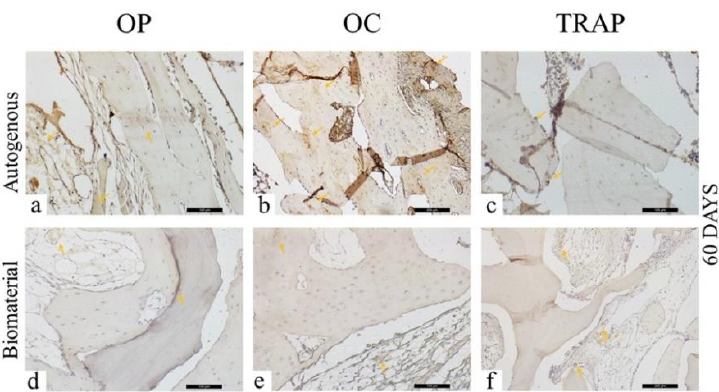
Figure 8. Osteopontin (OP), Osteocalcin (OC), and Tartrate-resistant Acid Phosphatase (TRAP) immunostaining at 60 days for the experimental groups. Immunolabeling is indicated by orange arrows. ( a ) OP immunostaining at 60 days in the AG; ( b ) OC immunostaining at 60 days in the AG; ( c ) TRAP immunostaining at 60 days in the AG; ( d ) OP immunostaining at 60 days in the BG; ( e ) OC immunostaining at 60 days in the BG; ( f ) TRAP immunostaining at 60 days in the BG.